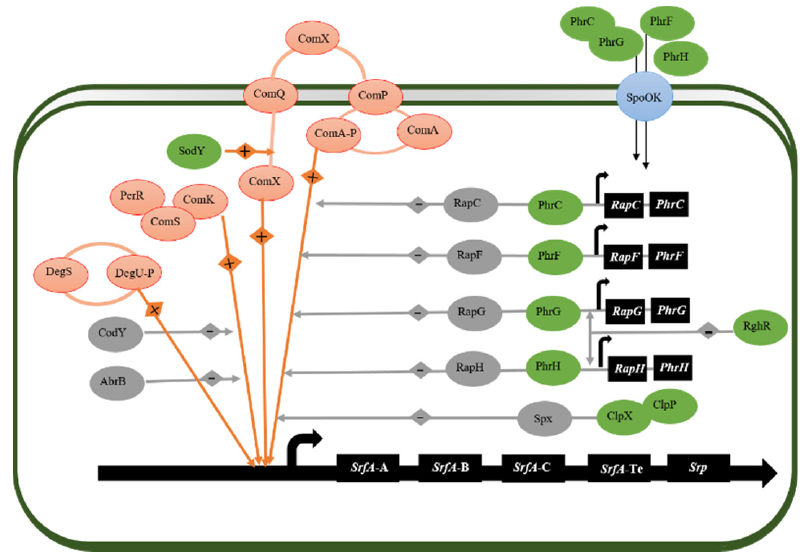
Figure 3. A gene regulatory model of surfacin biosynthesis. Orange indicates positive regulation and gray indicates negative regulation.